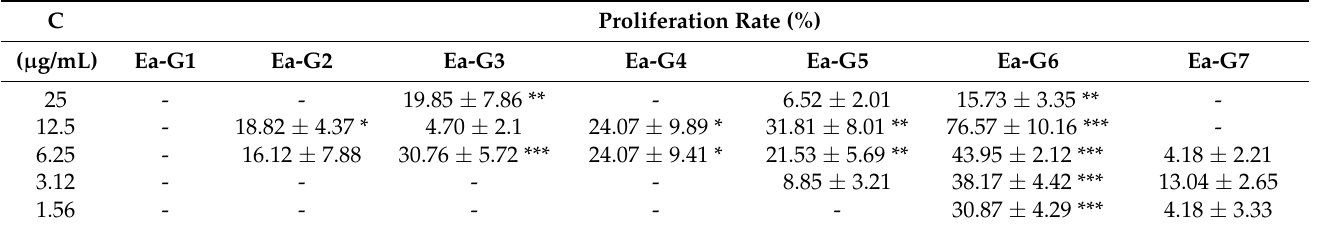
Table 2. Effects of each fraction in the TSZE-EA to promote the proliferation of NSCs.